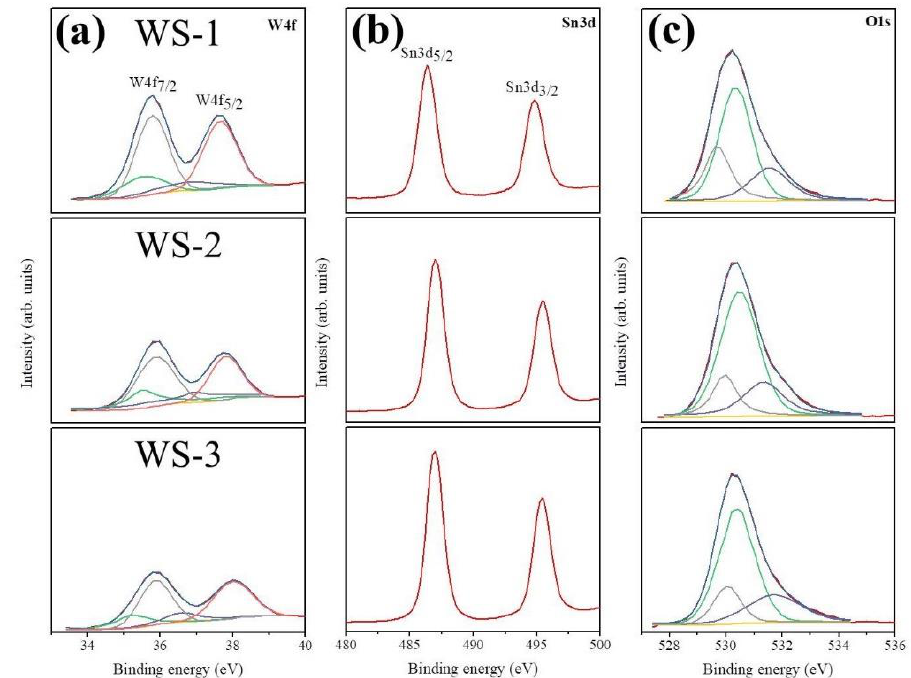
Figure 6. High resolution X-ray photoelectron spectroscopy (XPS) spectra of various WO 3 –SnO 2 composite nanorods: ( a ) W4f core-level doublet, ( b ) Sn3d core-level doublet, and ( c ) O1s peak.